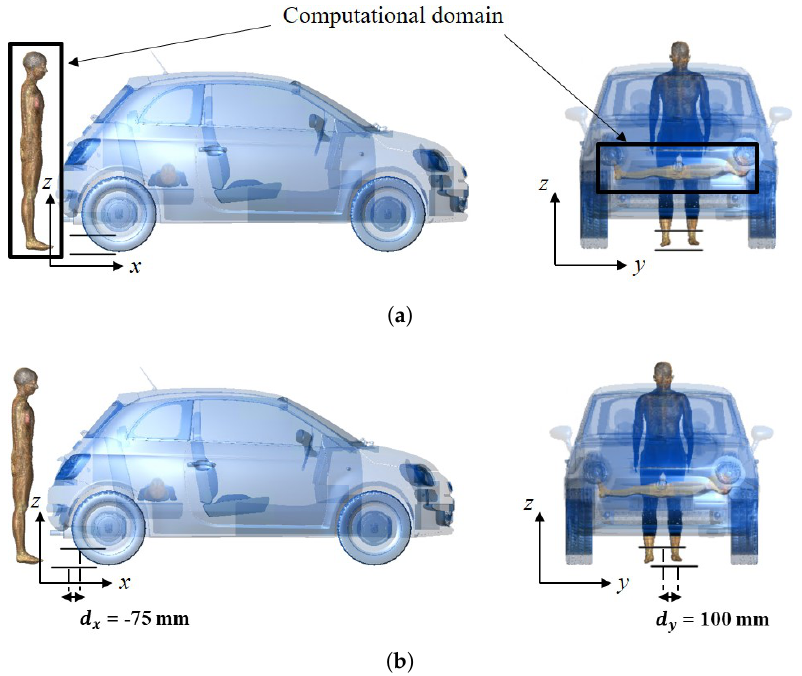
Figure 3. Exposure scenario #3: Roberta sleeping on the rear seats and Ella standing at the back of the car for the aligned ( a ) and misaligned ( b )